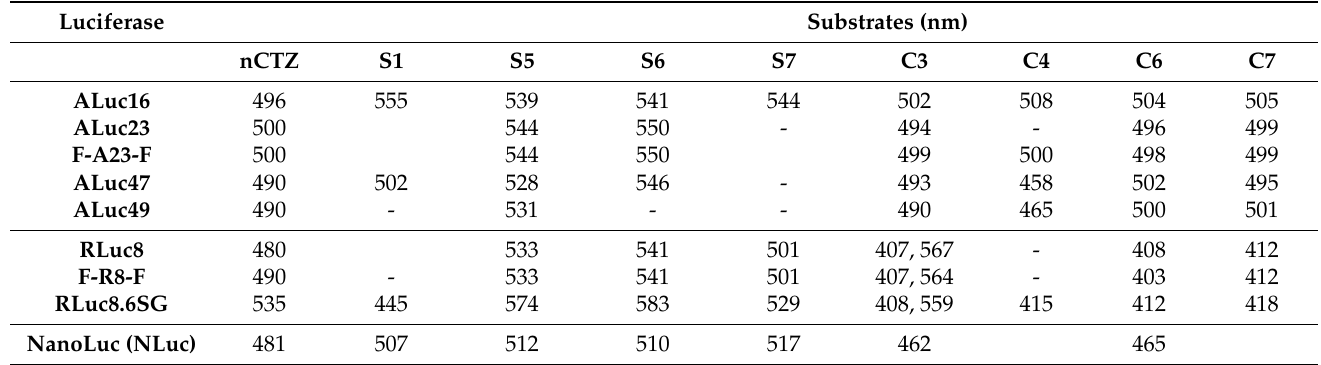
Table 1. The maximal BL wavelengths ( λ max ) of various marine luciferases in the presence of